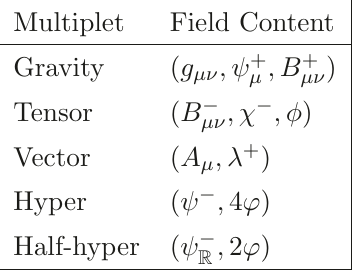
Table 1 . The massless multiplets of 6D = (1 , 0) supergravity. The sign exponents indicate chi- N rality. Whenever fermions are valued in the fundamental representation of the SU(2) R-symmetry, a symplectic Majorana condition can be imposed. The gravity multiplet contains, in addition to the metric tensor g µν , the gravitino ψ + , which is a spin 3 / 2 symplectic Majorana-Weyl fermion, and µ